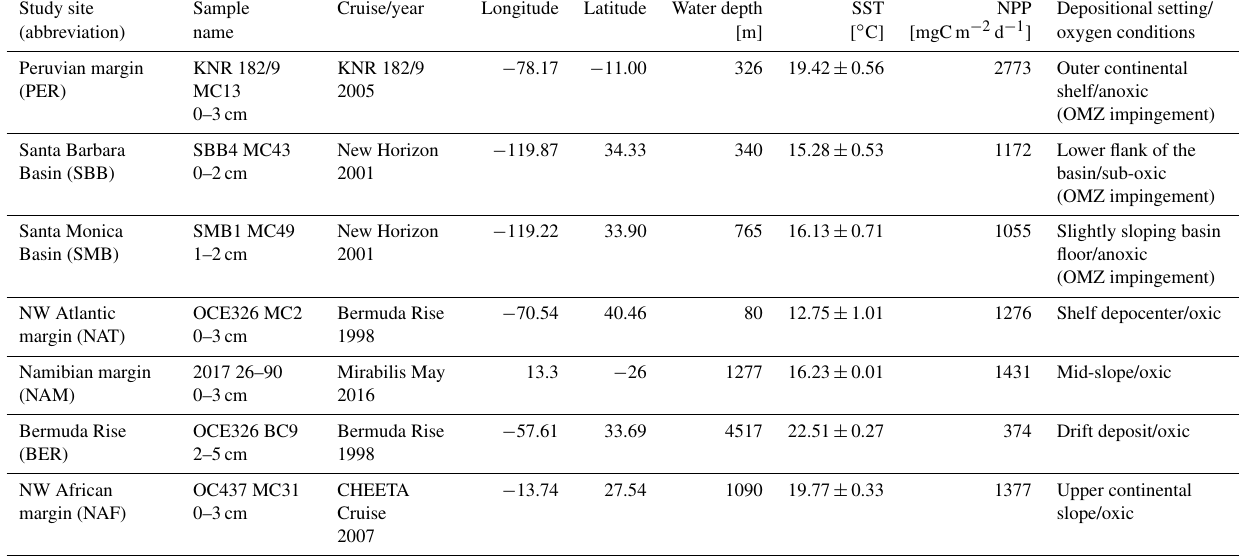
Table 1. Study sites. Annual mean SST was obtained from the World Ocean Atlas (WOA18) product with a grid of 0.25 ◦ longitude by 0.25 ◦ latitude (Locarnini et al., 2019) using Ocean Data View (ODV) software (Schlitzer, 2021). SST errors have been propagated considering the errors provided by ODV for the selected latitudinal and longitudinal resolution. MC: multi-core; BC: box core. Adopted from Ausín et al.